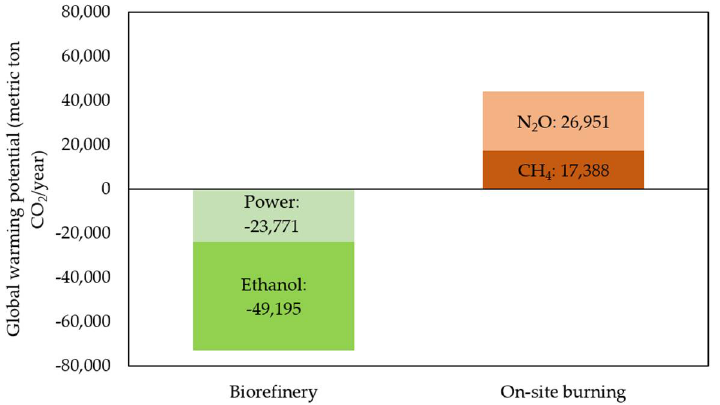
Figure 3. Contribution of global warming potential for the biorefinery and control on-site burning (the GWP for the power does not include the ethanol product).